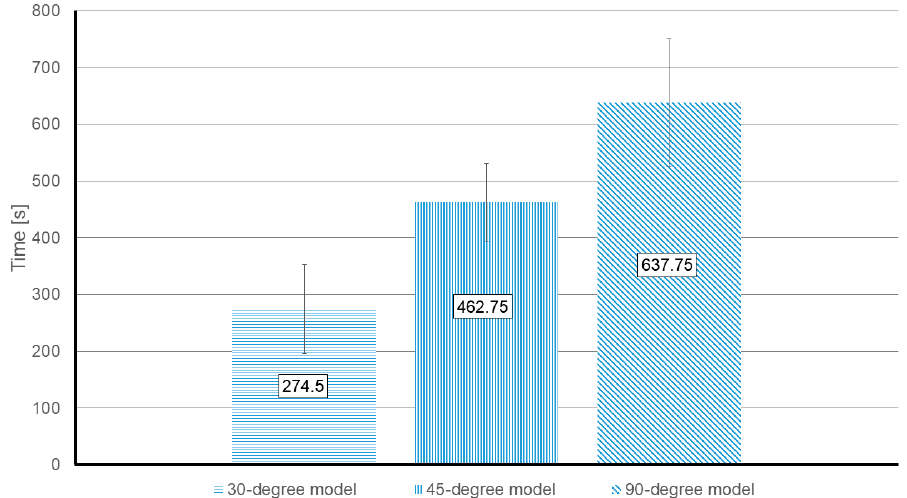
Figure 7 demonstrates that the required time is related to the inlets’ angle and increases from 274.5 s ( ± 68.02 s) in the 30-degree model to 637 s ( ± 113.3 s) in the 90-degree model. This is in agreement with previous numerical results.